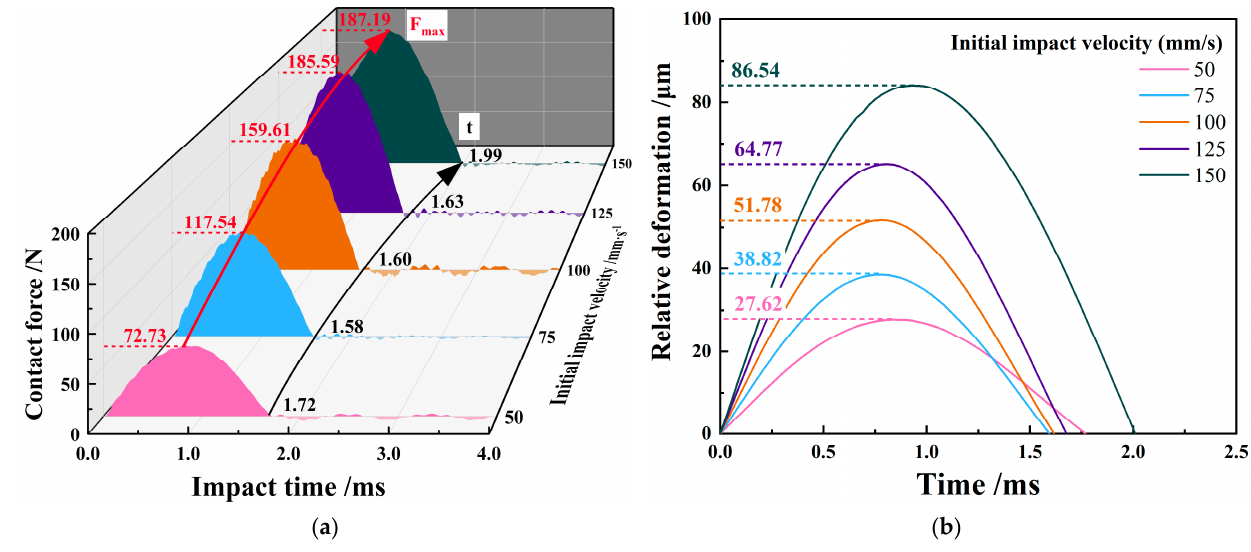
Figure 2. Curve of impact contact force and relative deformation with varying initial impact velocities. ( a ) Impact contact force vs. time; ( b ) relative deformation vs. time.